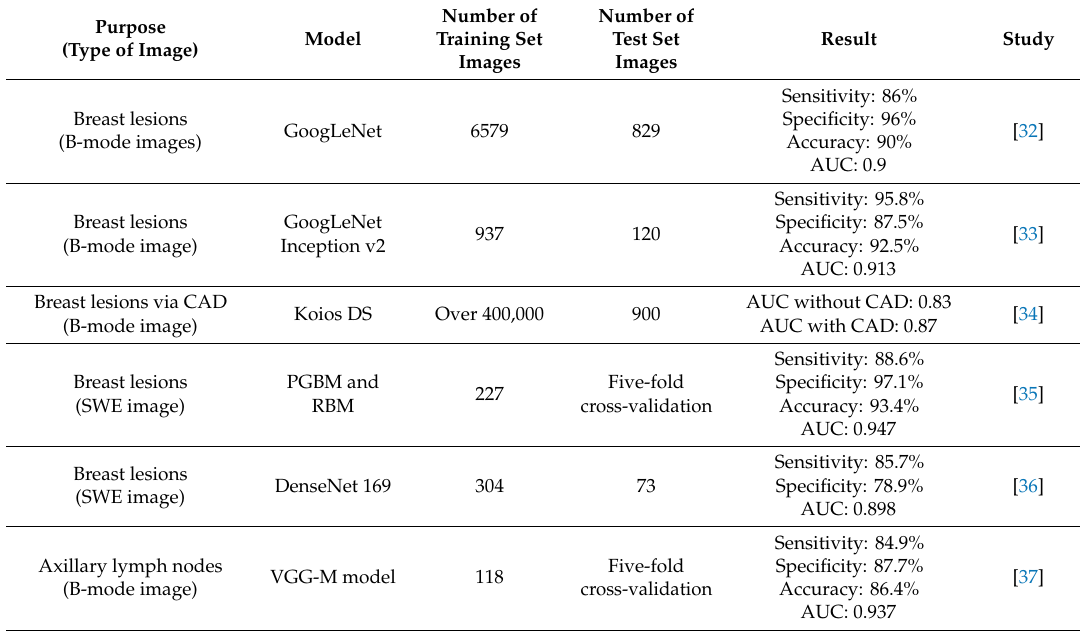
Table 1. Deep learning models for image classification.